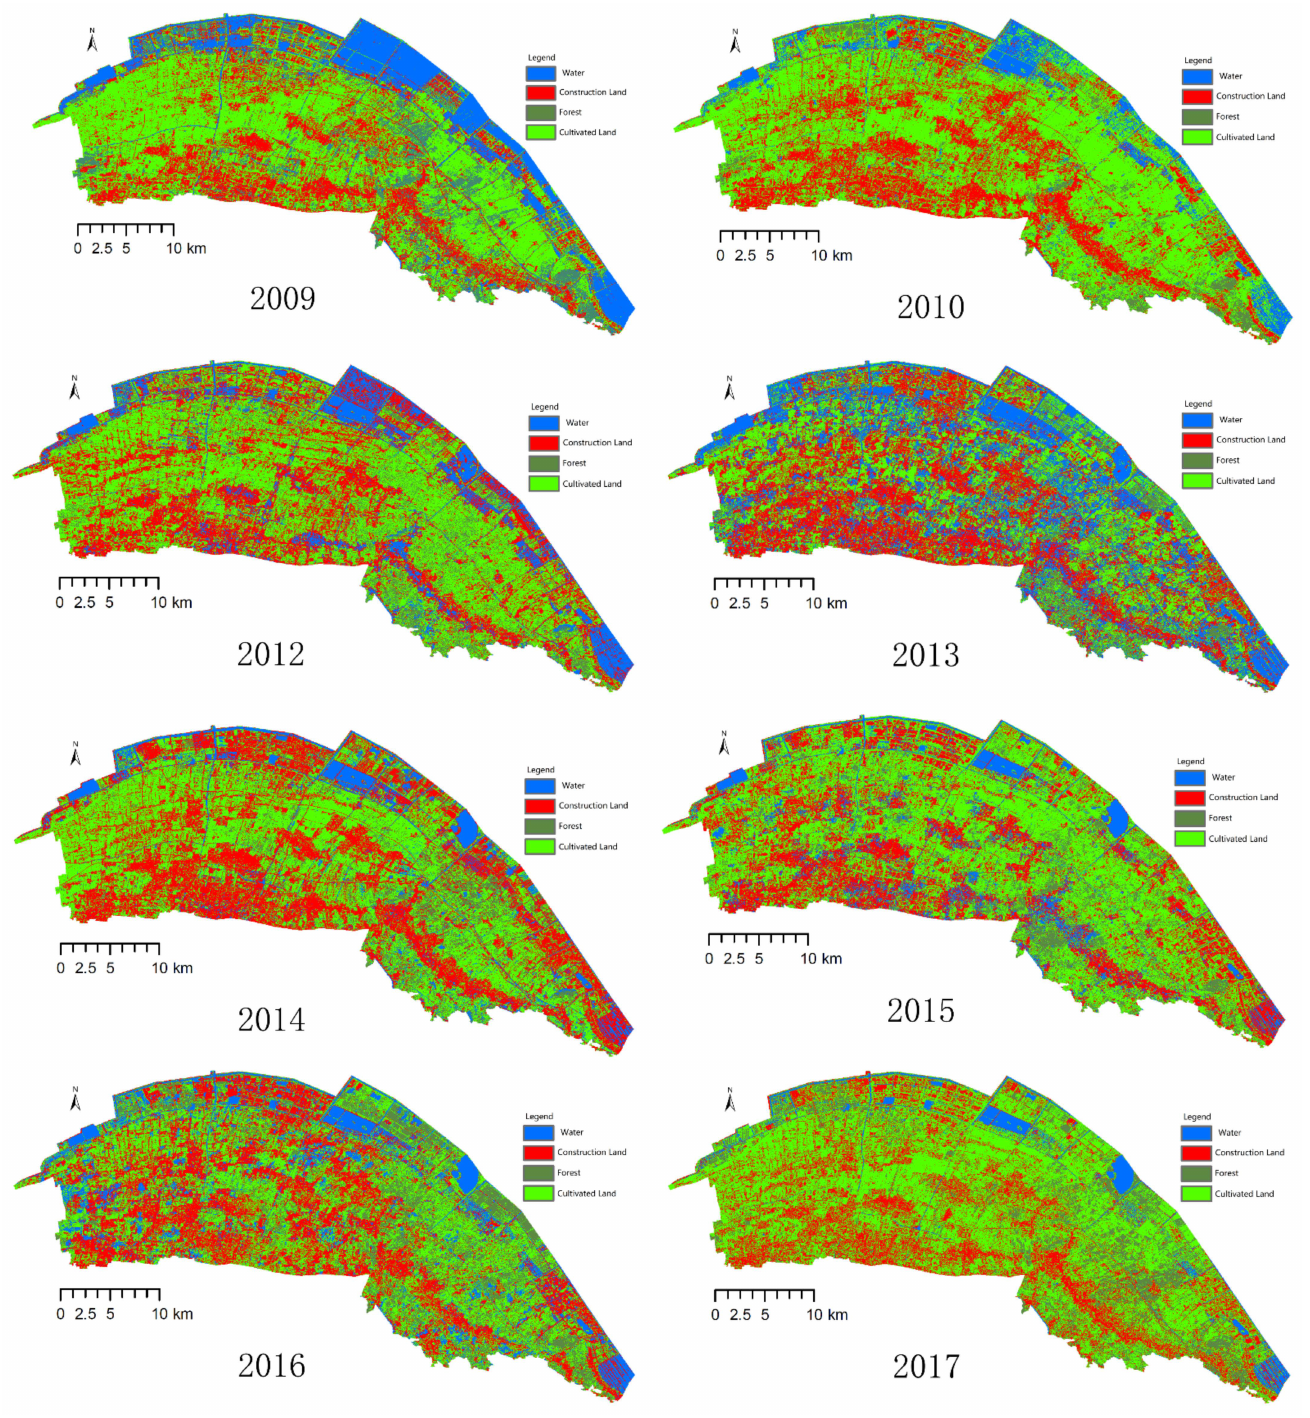
Figure 3. The land-use/land-cover contribution of the research area. (2009 to